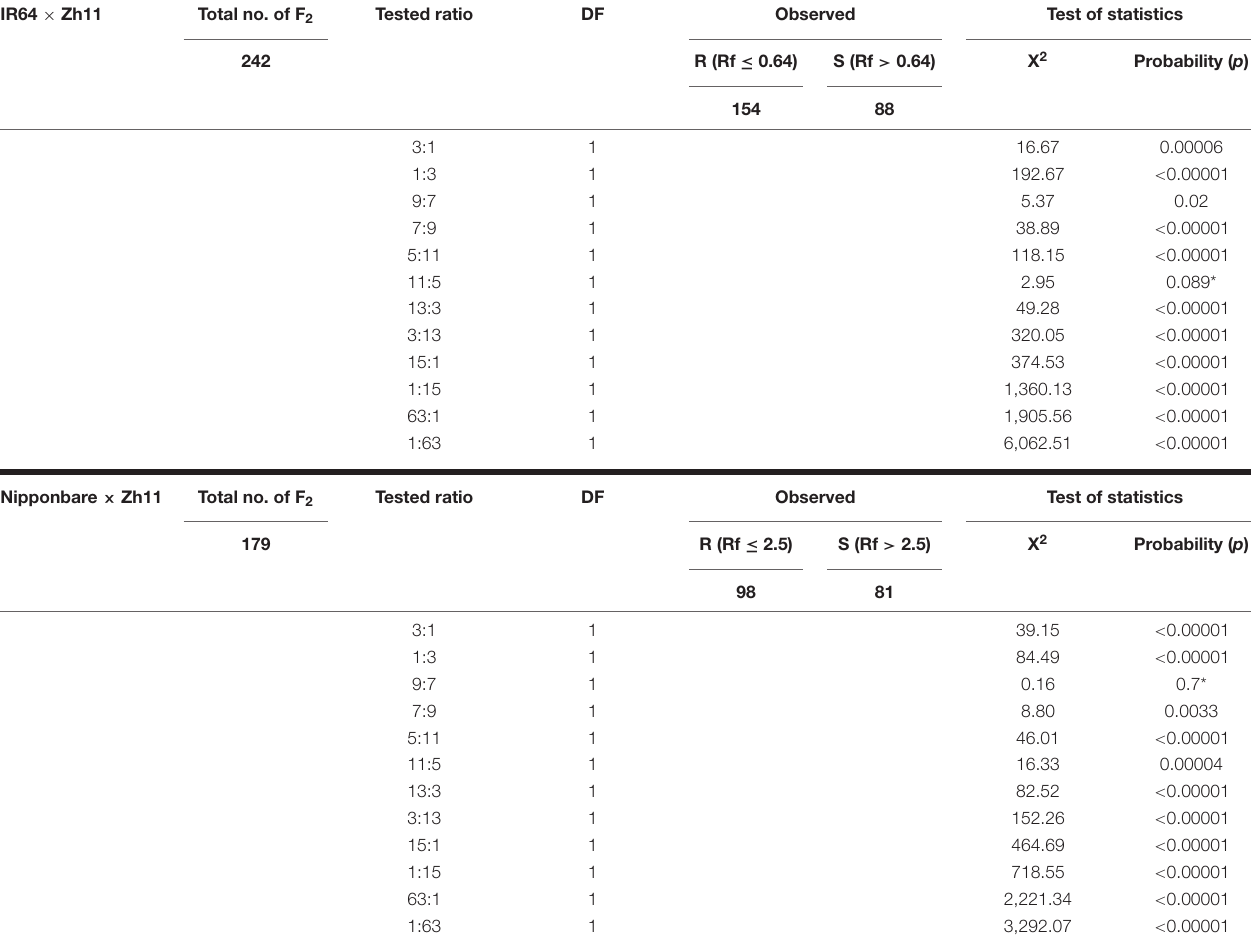
TABLE 1 | Segregation ratios for resistance to Meloidogyne graminicola in F 2 populations from two different crosses. IR64 × Zh11 Total no. of F 2 Tested ratio DF